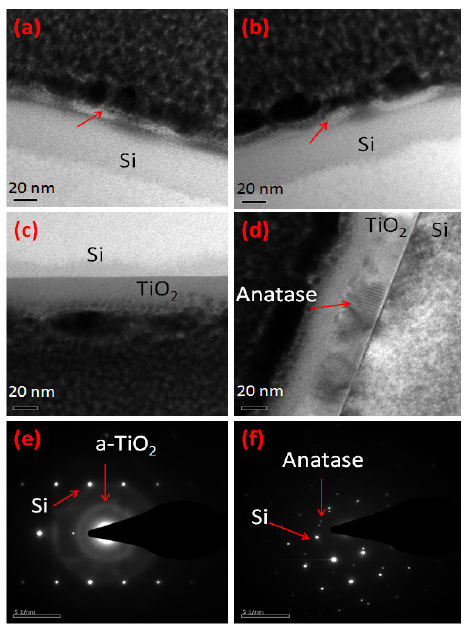
Figure 1. TEM (transmission electron microscopy) bright field images and selective-area diffraction patterns: ( a ) Bright field image of 125-cycle TiO 2 film (8 nm); ( b ) Bright field image of 250-cycle TiO 2 film (15 nm); ( c ) Bright field image of 530-cycle TiO 2 film (35 nm); ( d ) Bright field image of 1000-cycle TiO 2 (66 nm); ( e ) SAD pattern of 530-cycle TiO 2 and Si; and ( f ) SAD pattern of 1000-cycle TiO 2 and Si.